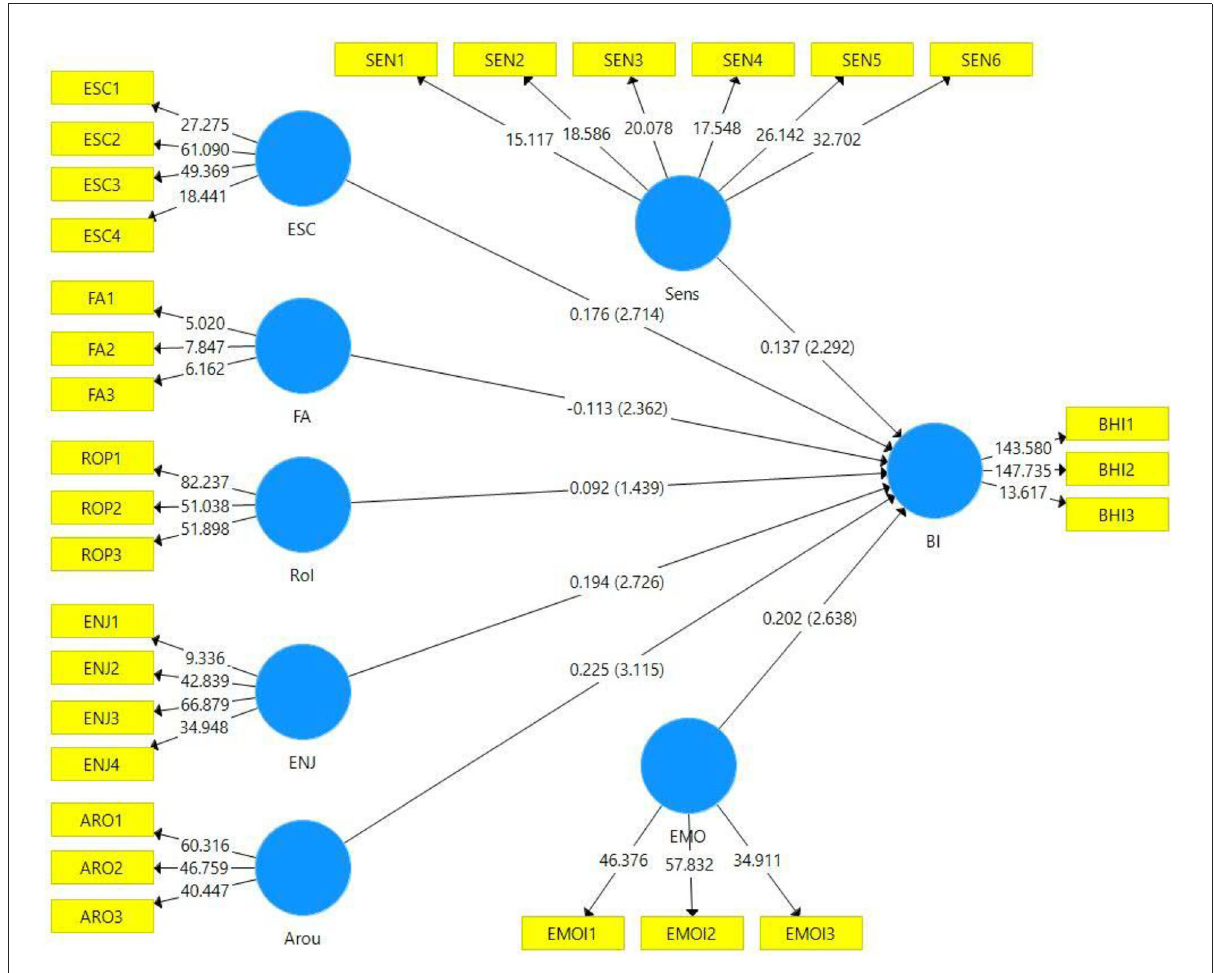
FIGURE2 The structural model